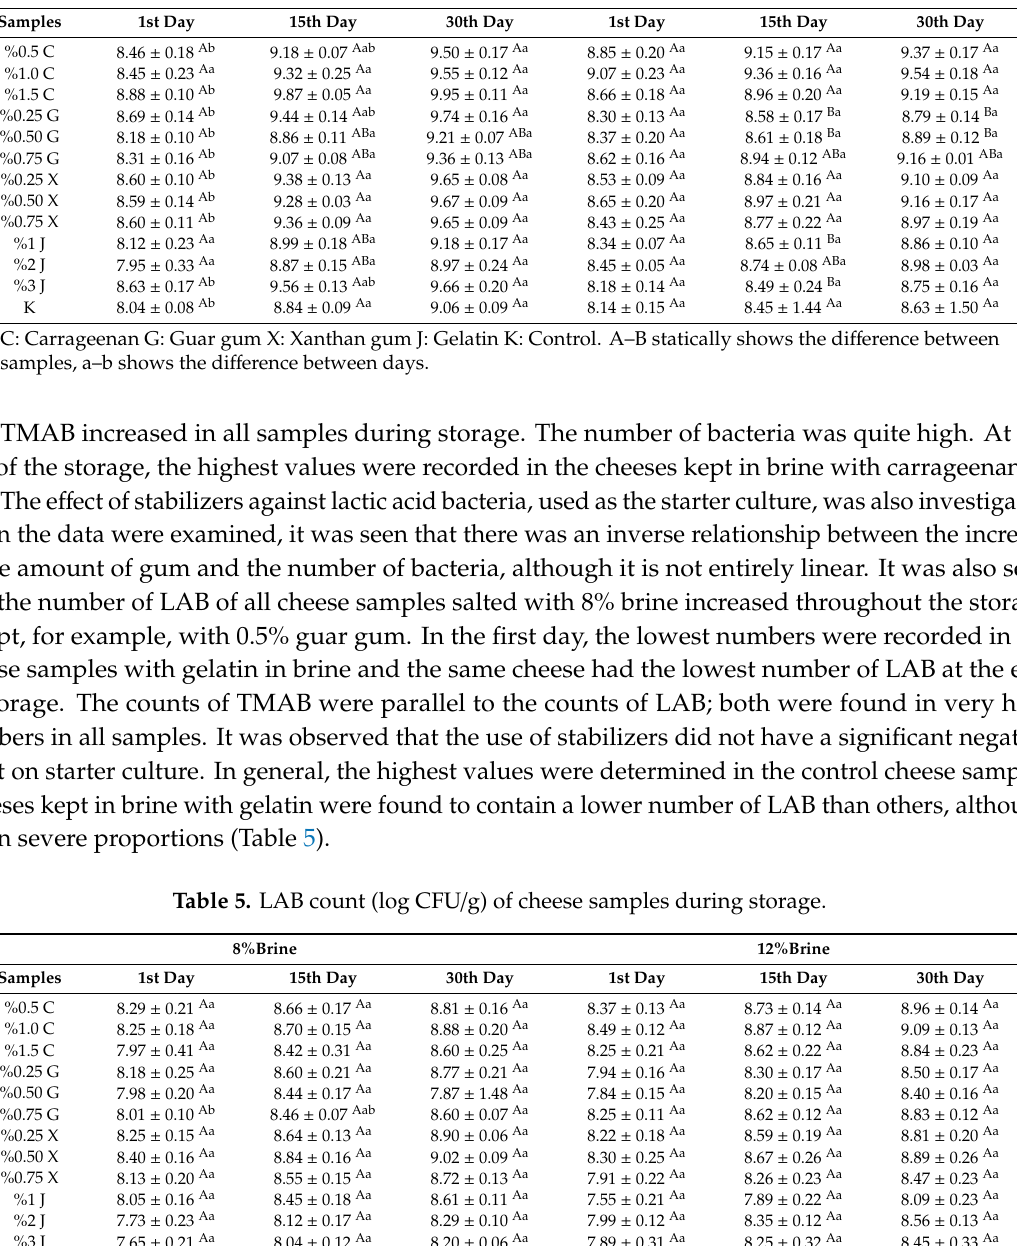
Table 4. TMAB (total mesophilic aerobic bacteria) count (log CFU / g) of cheese samples during storage. 8%Brine 12%Brine Samples 1st Day 15th Day 30th Day